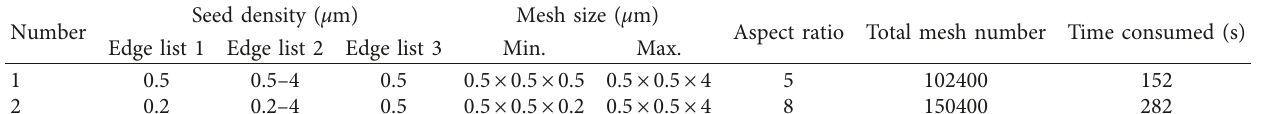
Table 1: Seed strategy in the mesh model (seed by size).